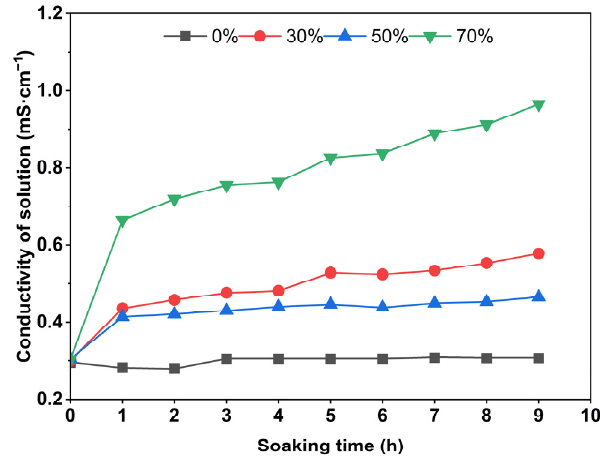
Figure 11. The release conductivity variation of deicing specimens at different times.